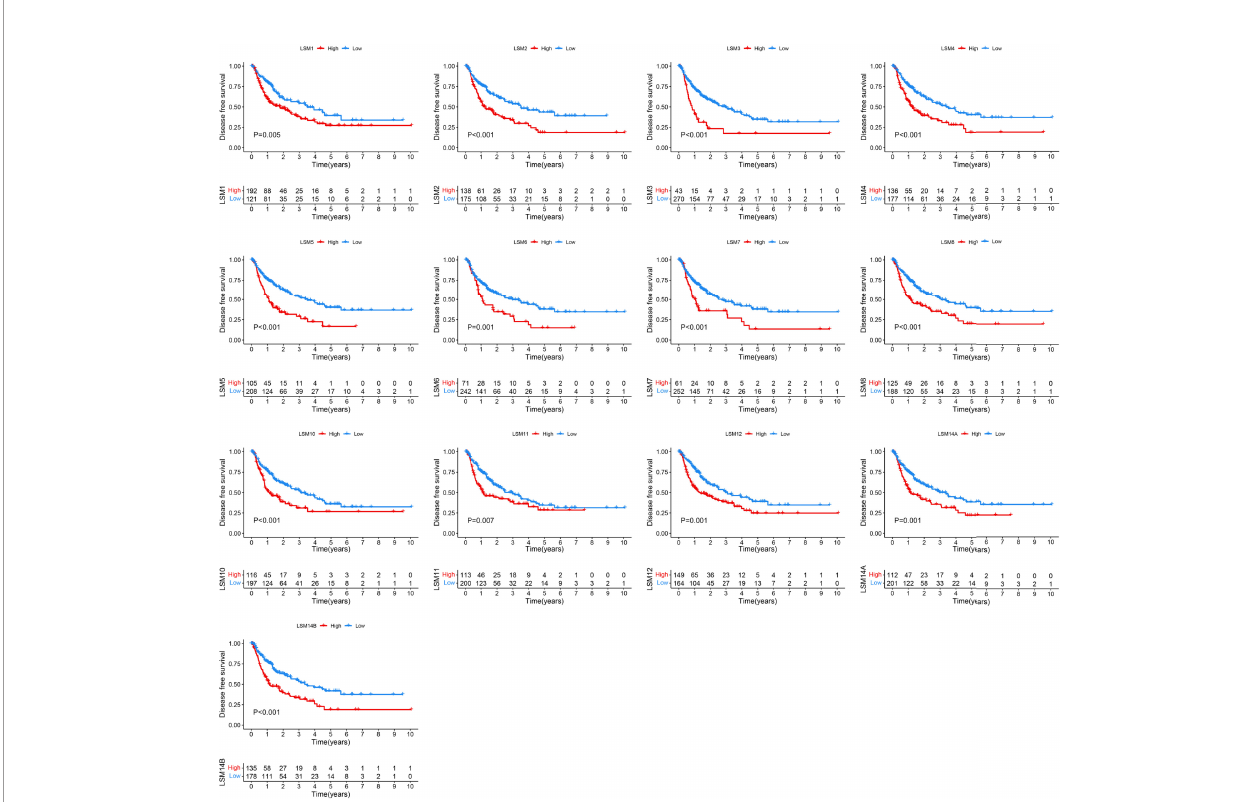
FIGURE 4 | KM survival curves for DFS of LSM family members in HCC. KM, Kaplan – Meier; DFS, disease-free survival; LSM, Smith-like (LSM) family members; HCC, hepatocellular